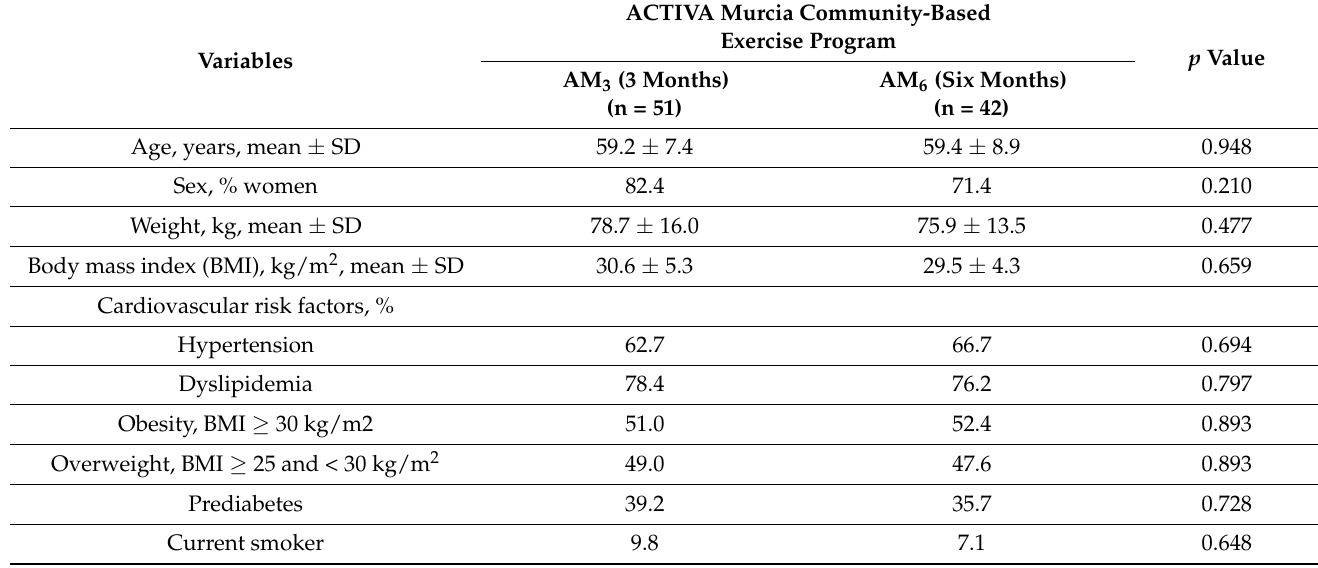
Table 1. Baseline characteristics of the study